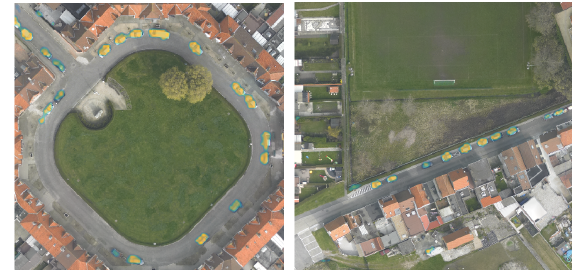
Figure 14. Samples from the complete classified area. While the classification of the vehicles is performed on the fusion of LiDAR data the results are displayed using the RGB data as background. The heatmap overlay uses the classification values Figure 12. PR-Curves of the training results derived by different provided by the data for the Medium-CNN with the HoG feature classification result for comparison.